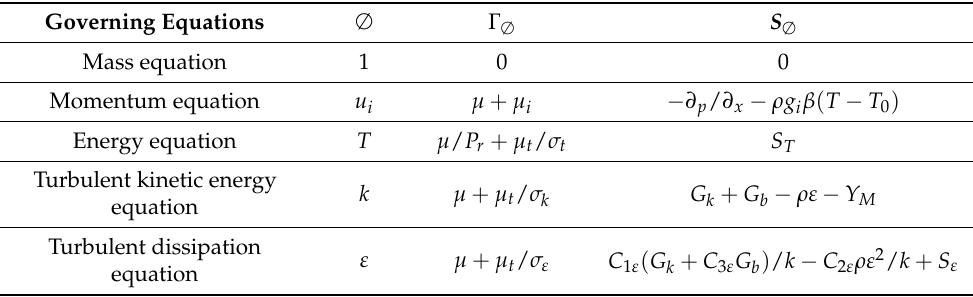
Table 3. Governing equations.